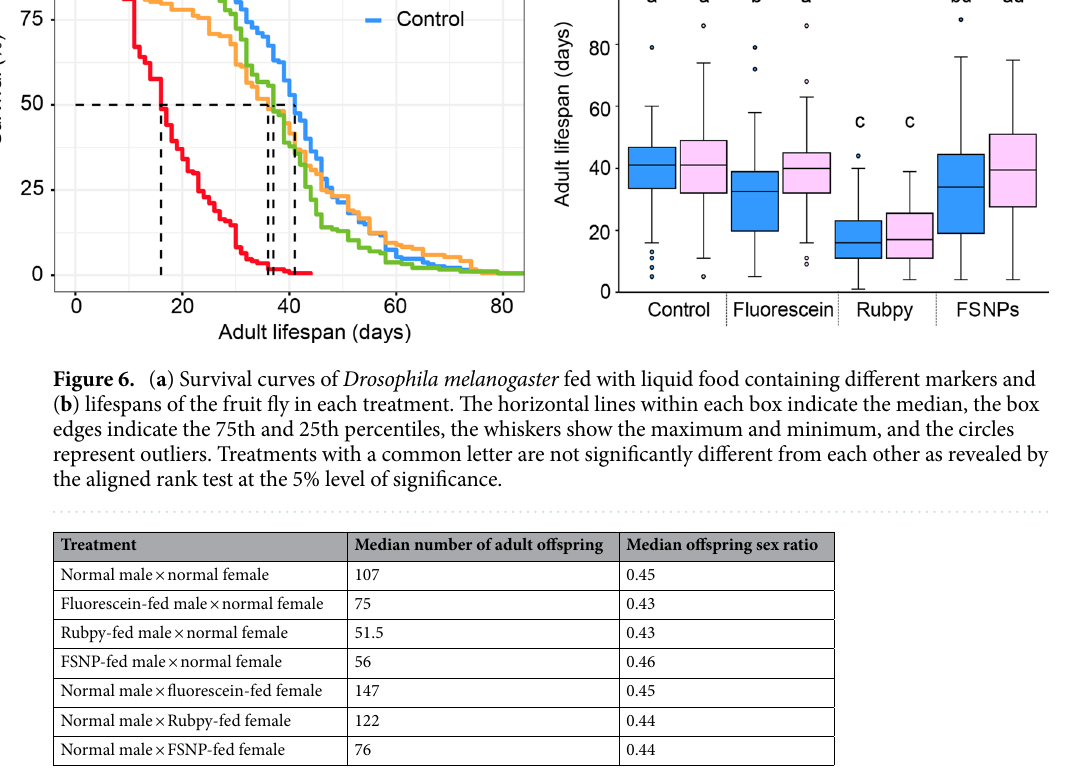
Table 2. Fertility of Drosophila melanogaster males and females during 10 days-period after feeding different markers.